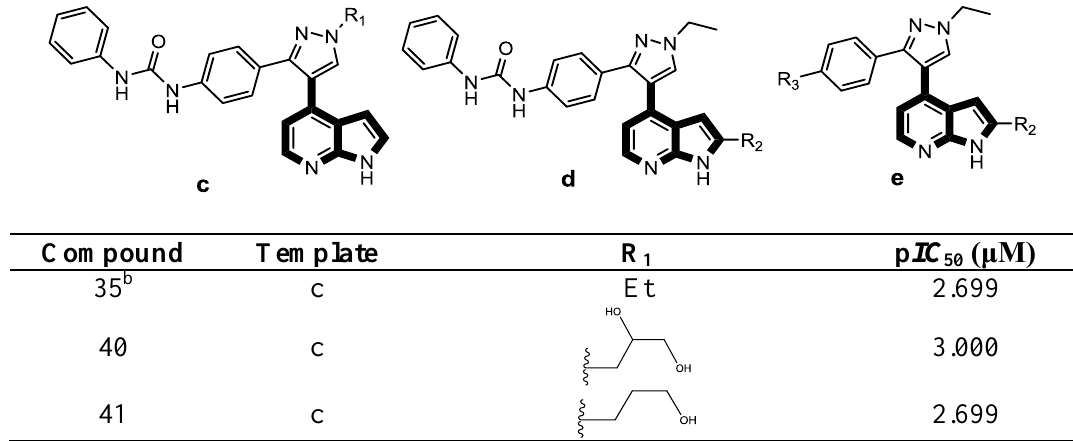
Table 2. Representative skeletons and molecular structures of GSK1070916 derivatives and their binding affinity values (p IC 50